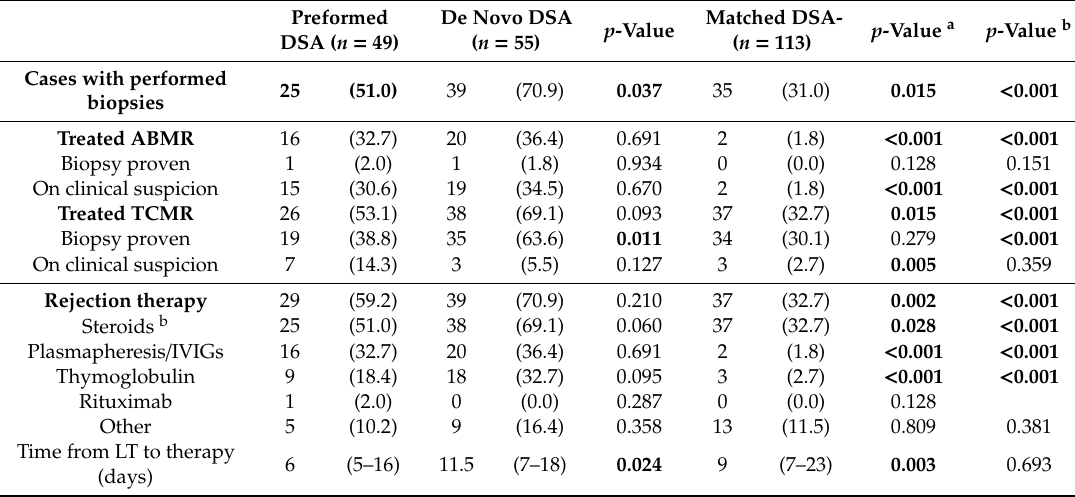
Table 5. Comparison of rejections and rejection treatments in LT organ recipients within the first postoperative year sorted by patients with de novo DSA versus preformed DSA and matched DSA-negative (matched DSA)